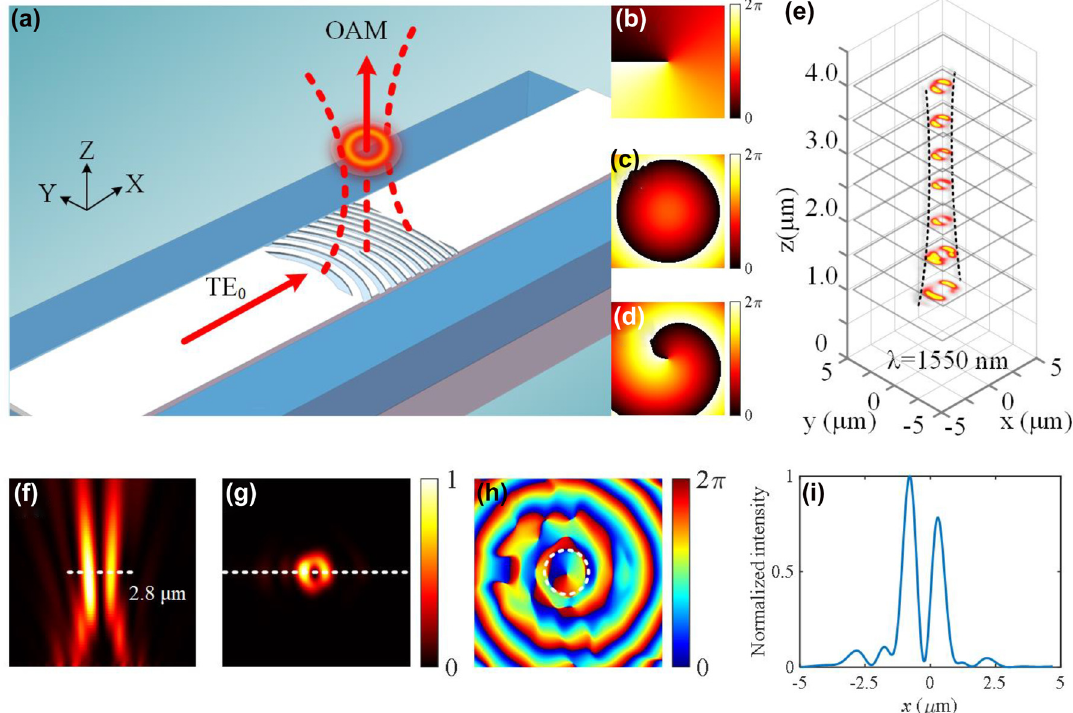
Figure 7: Focused vortex beam generation. (a) Schematic of the focused vortex beam generation. (b–d) The spiral phase, parabola phase, and superimposed phase distributions. (e) The simulated intensity distributions on the different focal planes at the wavelength of 1550 nm. (f) The beam on the xy plane on the focal simulated intensity profiles on the xz plane. (g, h) The simulated intensity and phase profiles of the generated OAM -1 mode along the x -axis for the figure plane. (i) Normalized intensity spectra of the focused OAM − 1